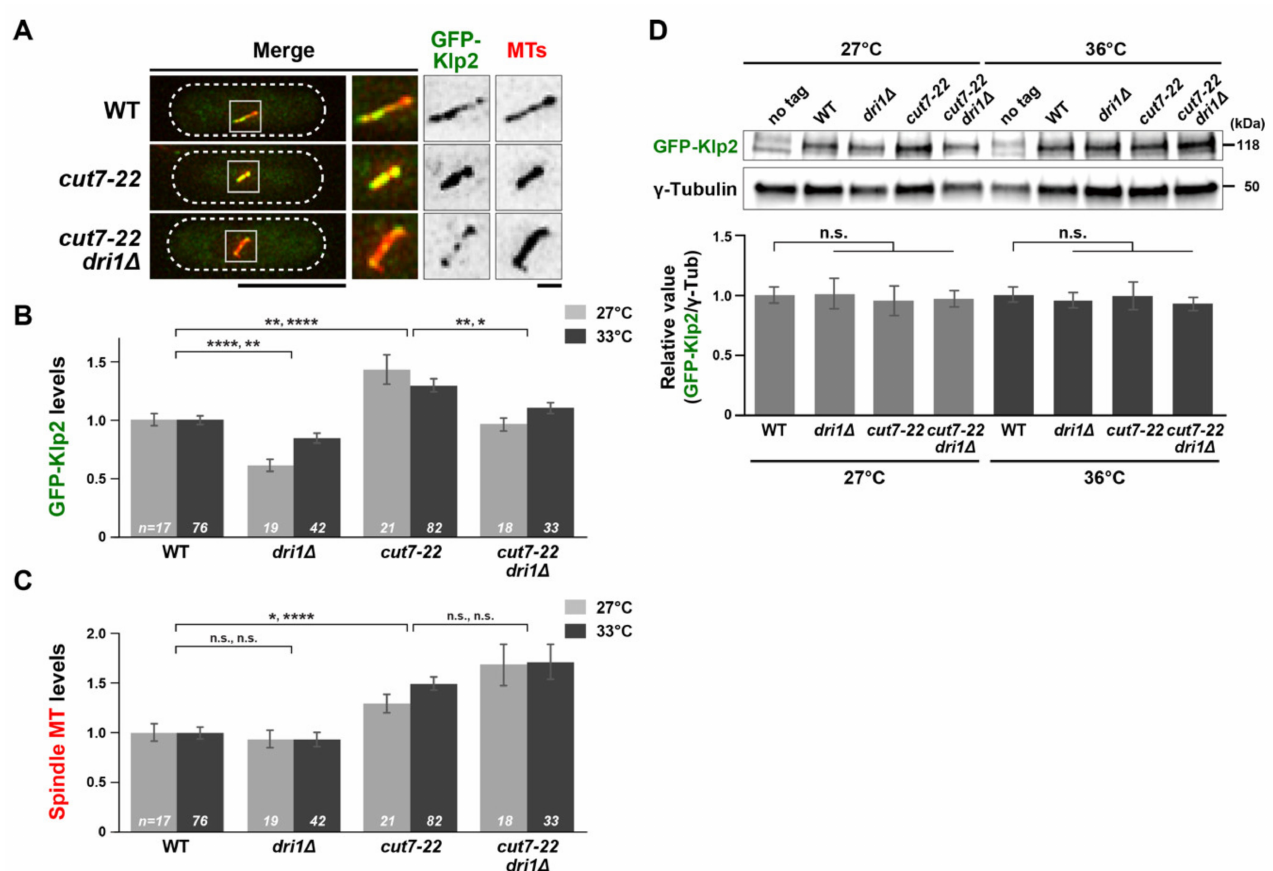
Figure 2. Dri1 is required for the Klp2 localization on the spindle microtubules. ( A ) Representative images showing mitotic localization of GFP-Klp2 on the spindle microtubule are presented in indicated cells. All strains contain GFP-Klp2 and mCherry-Atb2 (a microtubule marker). Cells were incubated at 27 ◦ C. The cell peripheries are outlined with dotted lines, and areas containing spindle microtubules (squares) are enlarged in the three panels on the right-hand side. Scale bars, 10 µ m (bottom left) and 1 µ m (bottom right). ( B , C ) Quantification of GFP-Klp2 levels on the spindle microtubule ( B ) and spindle microtubules ( C ). Individual strains shown in ( A ) were grown at 27 ◦ C, and a half of each culture was shifted to 33 ◦ C, while the remaining half was kept at 27 ◦ C. Fluorescence intensities were measured 2 h later. Then, 33 ◦ C was used as the restrictive temperature, as fluorescence signals of GFP-Klp2 were quenched rapidly at 36 ◦ C, which made quantitative measurement of GFP-Klp2 signal intensities difficult. The total values of GFP-Klp2 fluorescence intensities were divided by the spindle length in each cell. The values obtained from wild-type cells incubated at 27 ◦ C and 33 ◦ C were set as 1 and compared with those from other strains incubated at the same temperature. All p -values were obtained from the two-tailed unpaired Student’s t -test. Data are presented as the means ± SE ( ≥ 17 cells). *, p < 0.05, **, p < 0.01, ****, p < 0.0001, n.s., not significant. ( D ) Quantification of the total levels of GFP-Klp2 protein in whole-cell extracts. Indicated strains containing GFP-Klp2 and a control non-tagged strain were grown at 27 ◦ C or 36 ◦ C for 2 h, and protein extracts were prepared, followed by immunoblotting with anti-GFP and anti– γ -tubulin antibodies. Relative amounts of each GFP-Klp2 protein were normalized using those of γ -tubulin as a control. Results are given as the means ± SE ( n = 5). The relative amounts obtained from wild-type cells incubated at 27 ◦ C and 36 ◦ C were set as 1 and compared with those from other strains incubated at the same temperature. Data sets were compared with a two-tailed unpaired Student’s t -tests (n.s., not